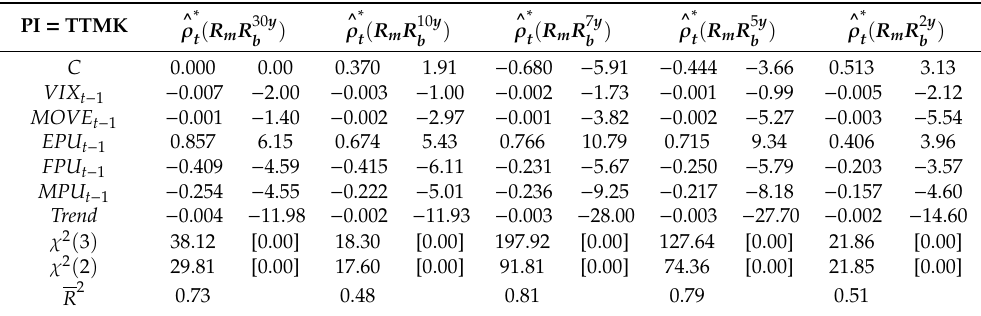
Table 4. Estimates of aggregate and categorical EPU, FPU, and MPU, and on stock (TTMK)–bond return